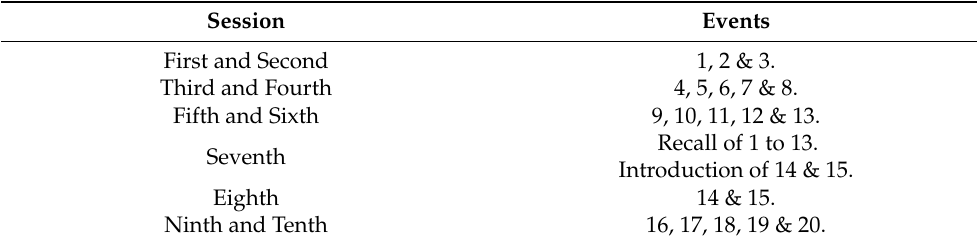
Table 5. Events worked on by each